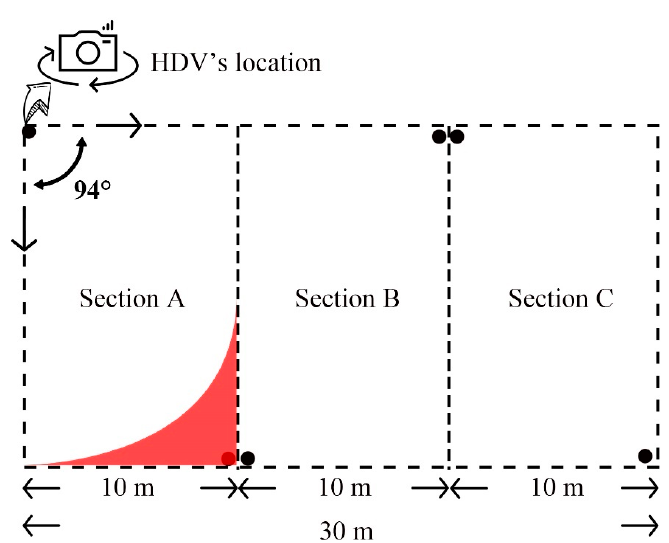
Figure 4. The conversation behavior in each section of the survey zone.